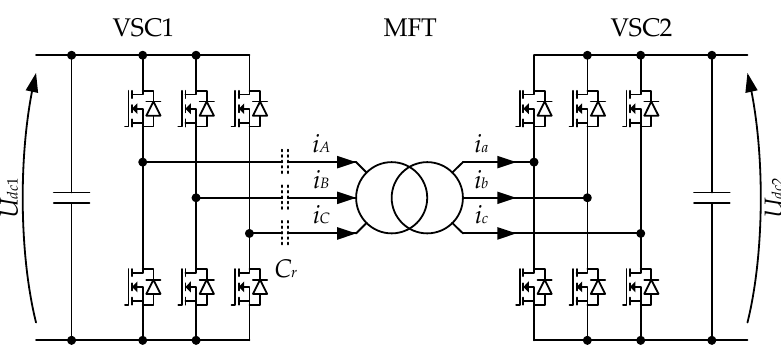
Figure 1. Three-phase isolated dc-dc converter circuit diagram; C r is the optional resonant capacitor. The performance of the converter highly depends on the MFT and its equivalent circuit